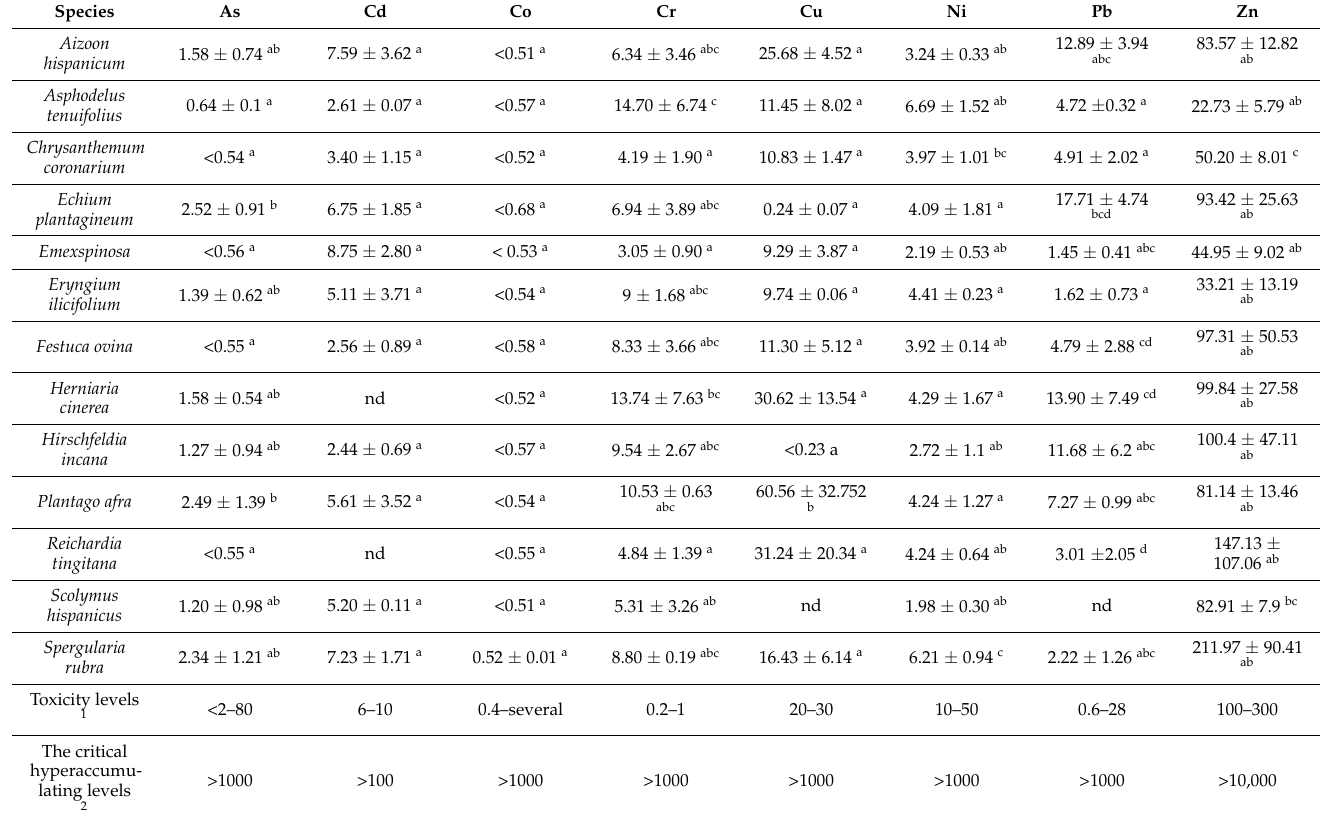
Table 4. Trace metals concentration in shoots (mg/kg dry weight) of collected plants species growing in phosphate wastes cover in Kettara abandoned mine (each value represents the mean ± standard deviation of at least 3